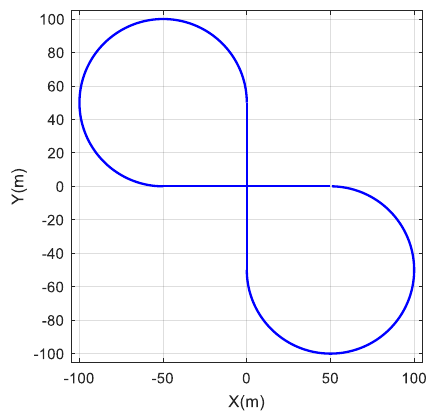
Figure 9. Lemniscate – shape path.